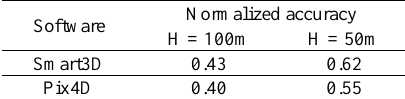
Table 6. Normalised accuracy